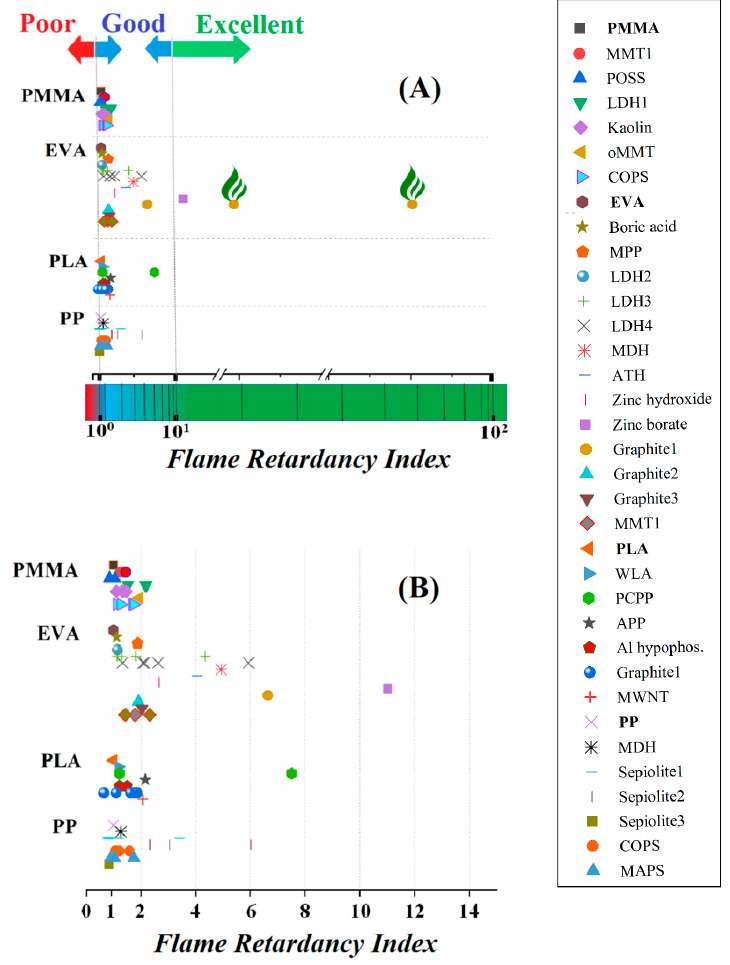
Figure 3. The calculated FRI for PLA, PP, PMMA, and EVA thermoplastic composites